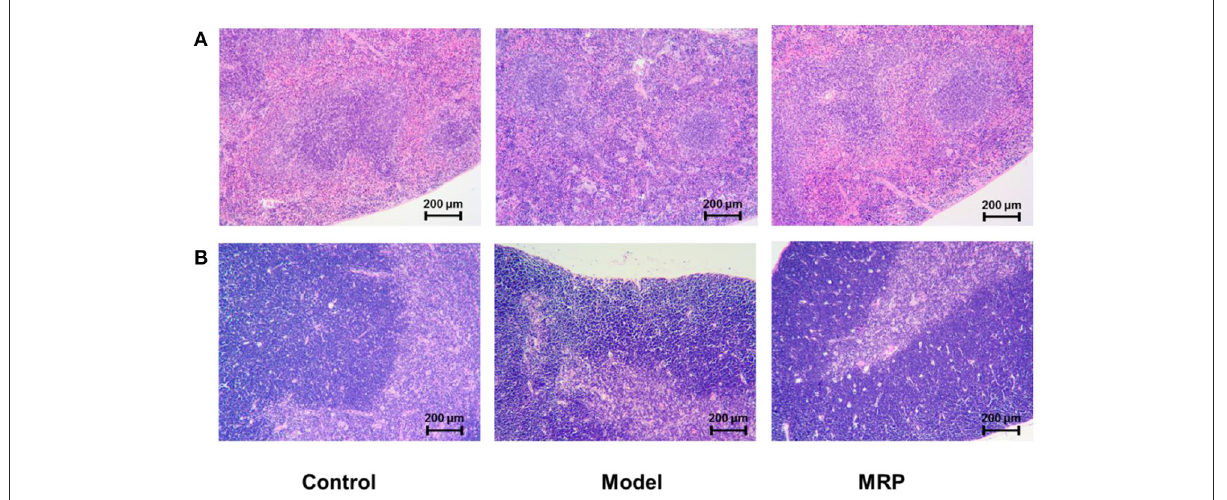
FIGURE5 Histomorphology of the spleen (A) and thymus (B) in mice ( × 100).